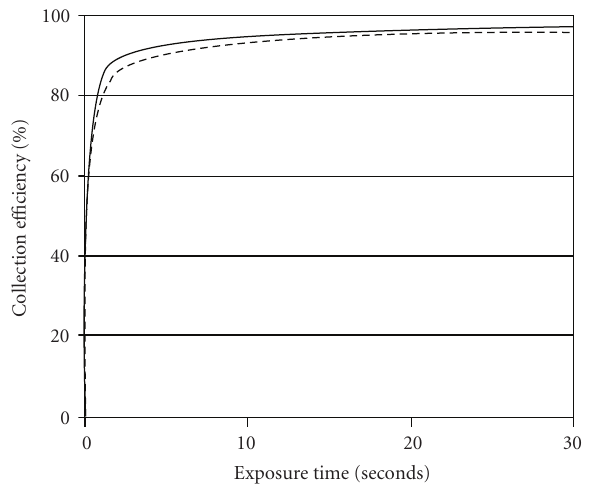
Figure 5: Simulated collection e ffi ciency of the radiolytic yield measurement cell with respect to time exposed to the alpha particle beam; Solid: H 2 O 2 , dashed: O 2 .